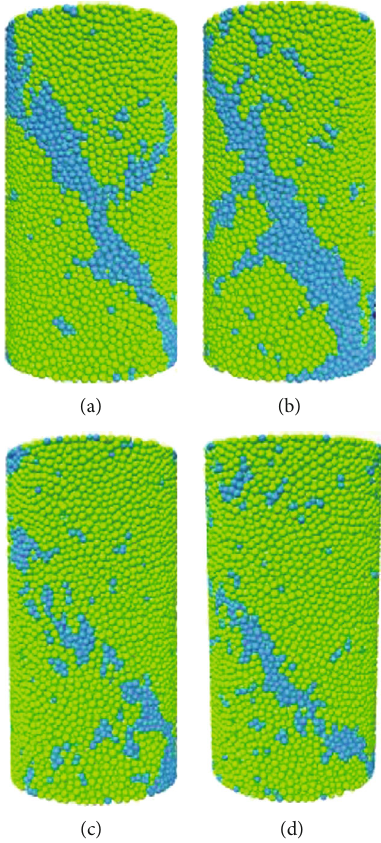
Figure 8: Macroscopic failure modes of redstone under di ff erent con fi ning pressure by PFC 3D : (a) 5MPa; (b) 10 MPa; (c) 15MPa; (d) 20MPa.